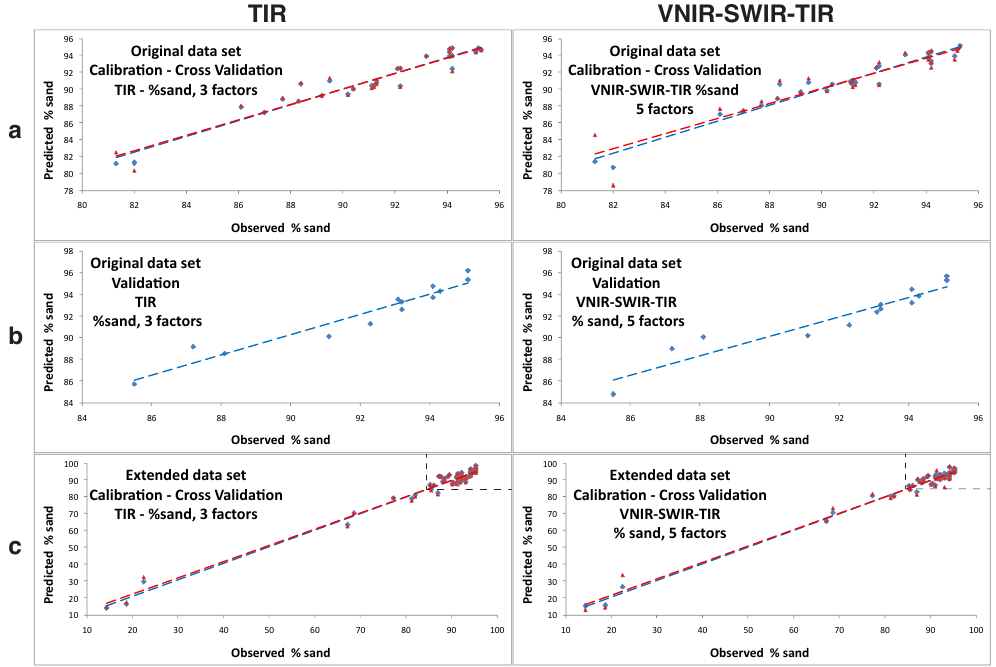
Figure 7. Observed (reference) sand content versus sand content predicted from the PLSR models for the TIR and the VNIR-SWIR-TIR spectral regions. ( a ) calibration (red) and internal cross-validation (blue); ( b ) external validation using a test dataset (blue) for the original dataset; ( c ) the results for the external dataset, calibration (red) and internal cross-validation (blue), where the dashed bordered area displays the data range from the original dataset.